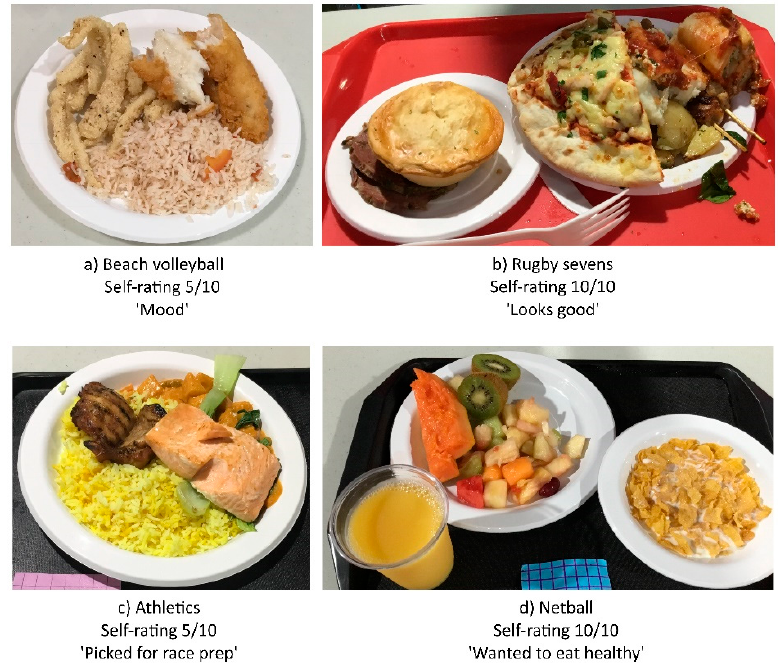
Figure 2. Sample photographs of meals, ratings and reason for choice.